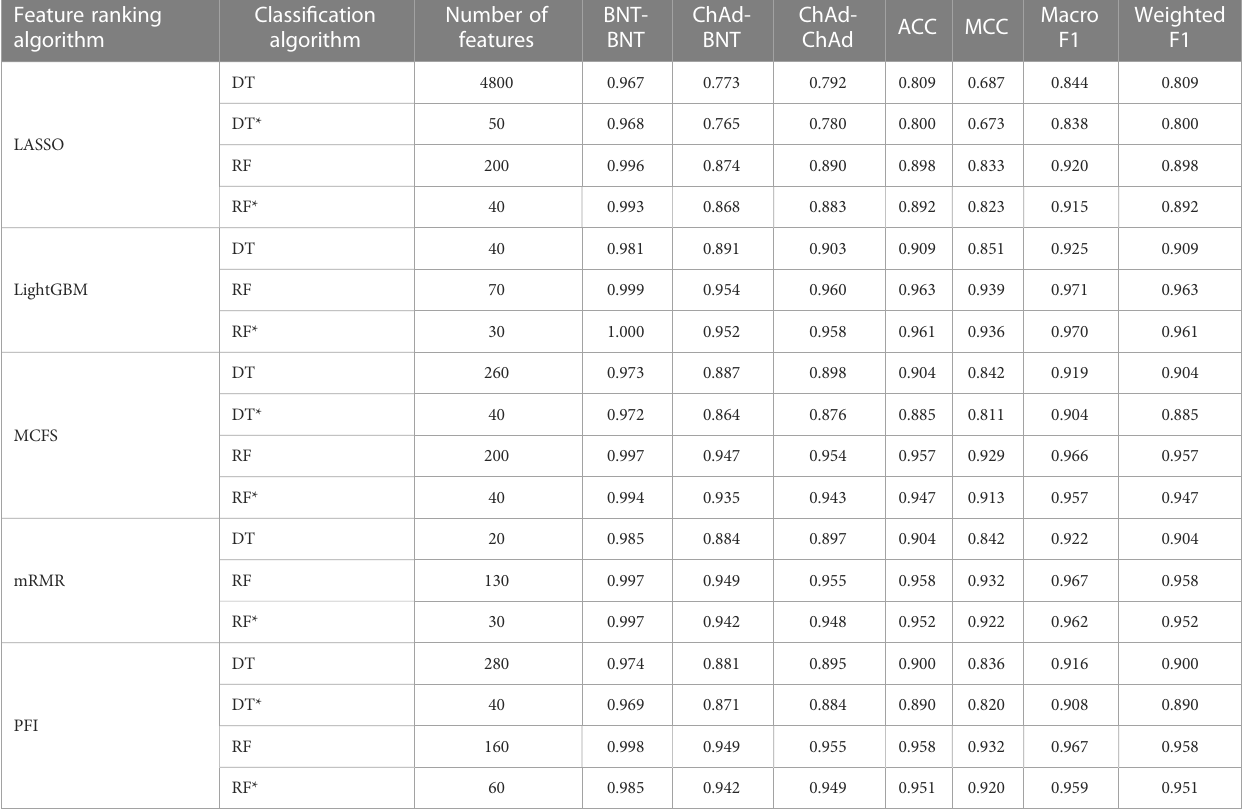
TABLE 3 Performance of key classi fi ers in CD4 + T cell. Feature ranking